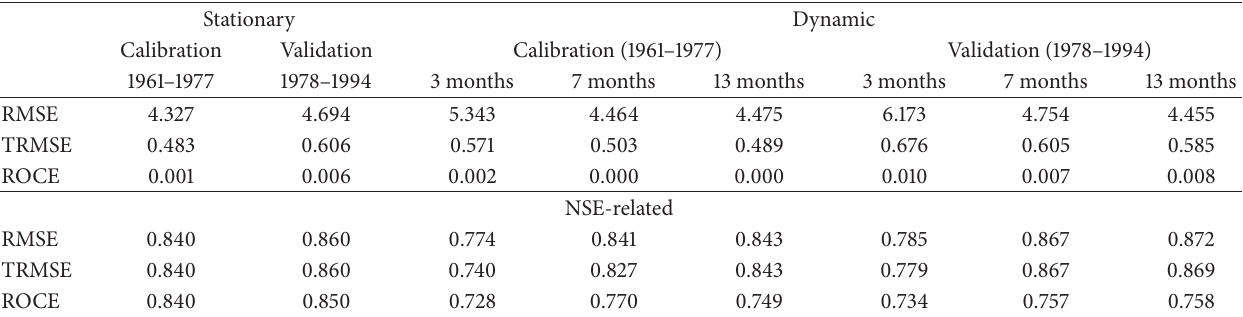
Table 2: OF and NSE-related values for the stationary and dynamic strategies of